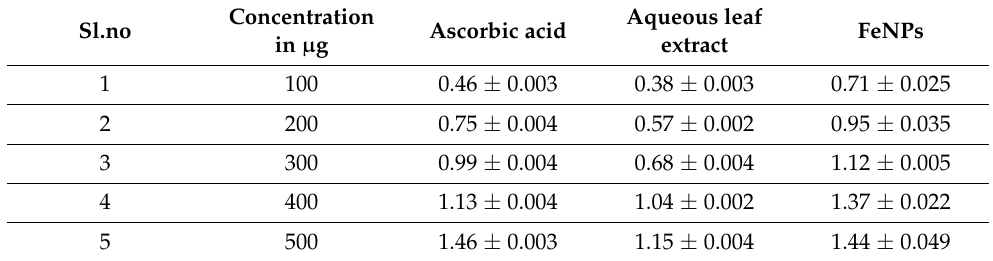
Table 2. FRAP assay of aqueous leaf extract of V. leucoxylon and its synthesized iron nanoparticles. Sl.no